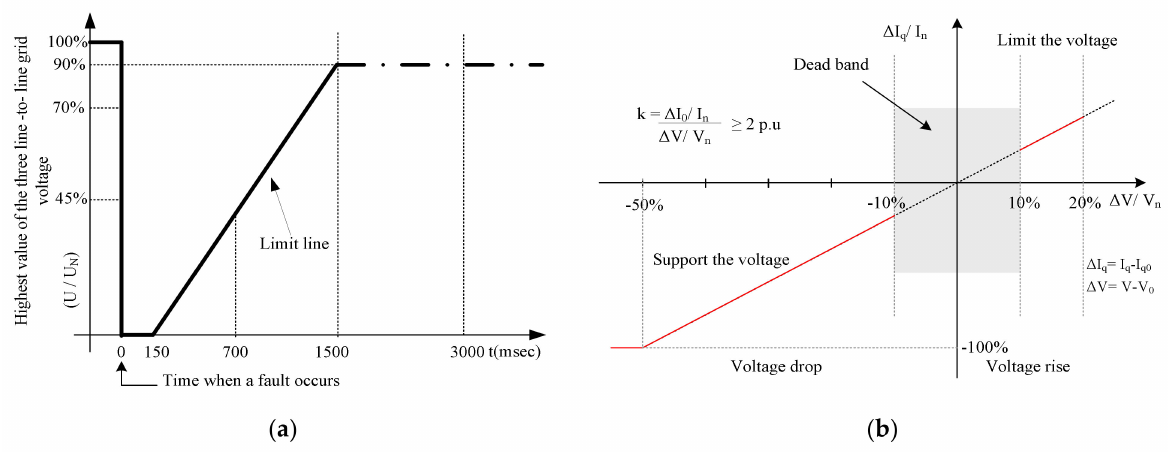
Figure 1. LVRT requirement: ( a ) voltage limit curves; ( b ) reactive current injection during